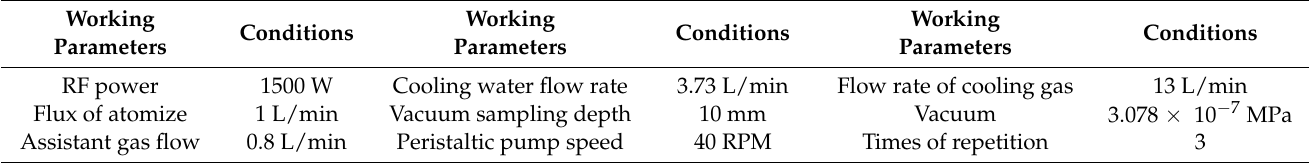
Table 2. Operational parameters for ICP −